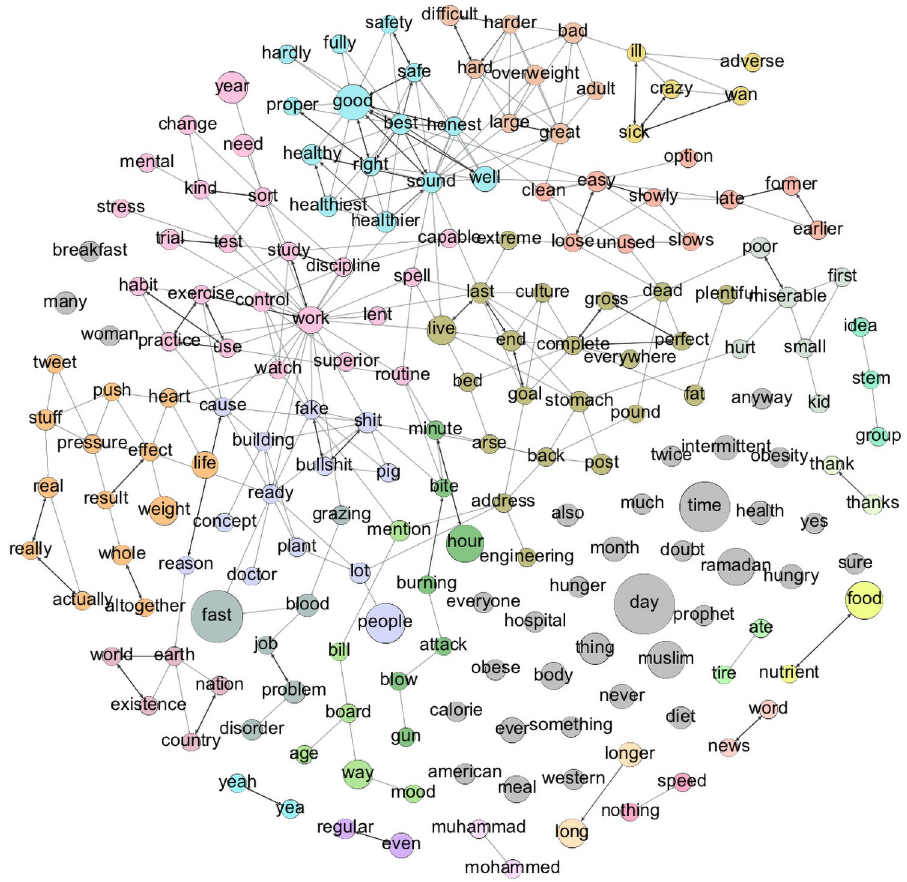
Fig 3. Text graph for the tweet replies text. This graph has 193 vertices (34 vertices are singletons), 572 edges, and 45 connected components. 112 edges represent direct synonym relationships, and 460 represent indirect synonym relationships. The size of each vertex reflects its frequency in the original text. Thick and thin edges indicate direct and indirect synonym relationships, respectively.